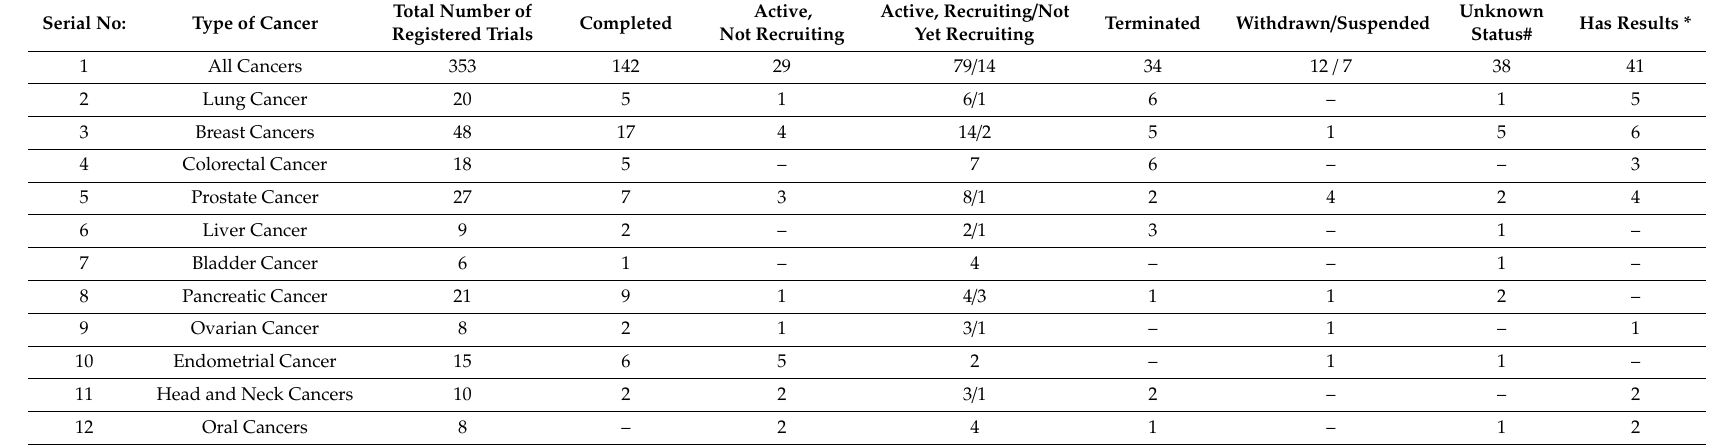
Table 2. Status of metformin administration-related clinical trials in various cancers (https: // clinicaltrials.gov /